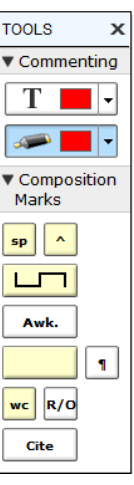
Figure 2. Screen shot of a peer review activity in PeerMark.